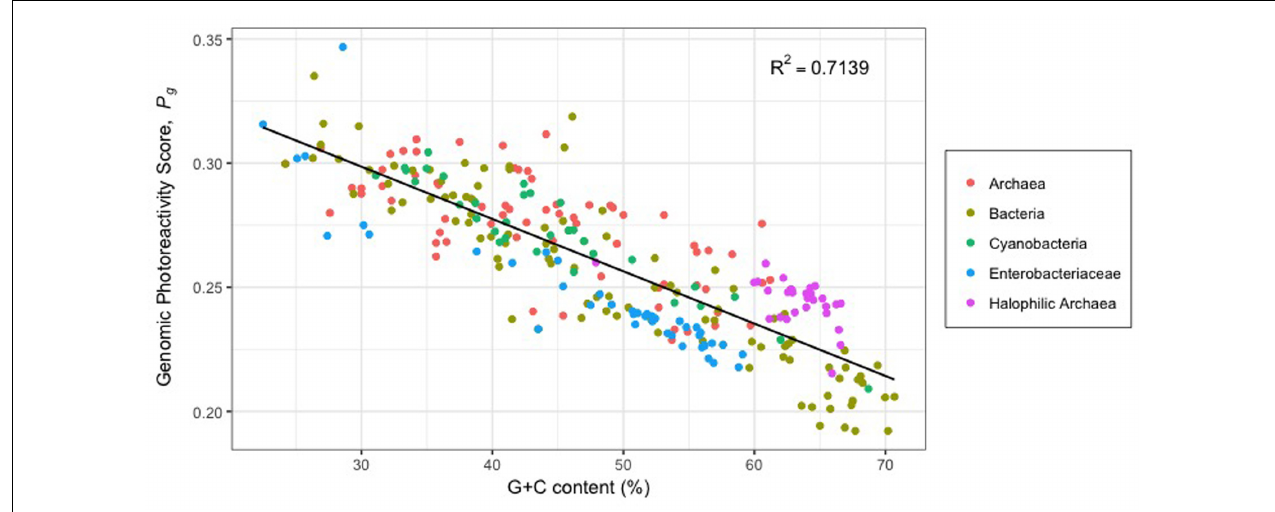
FIGURE 5 | Theoretical genomic photoreactivity based on bipyrimidine signature ( P g ) vs. G+C content (%) of 29 halophilic archaea and 243 other prokaryotic genomes (adapted from Jones and Baxter, 2016). P g is calculated as the weighted sum of a genome’s bipyrimidine incidences: P g = 1.73(TC i ) + 1.19(TT i ) + 0.61(CT i ) + 0.39(CC i ). Bipyrimidine incidence corresponds to bipyrimidine frequency divided by genome size. Weighting coefficients represent the intrinsic photoreactivity of each bipyrimidine sequence, determined experimentally by Matallana-Surget et al. (2008) as the ratio between the frequency of photoproducts (CPDs and (6-4)PPs) and bipyrimidine incidences in DNA with varying G+C